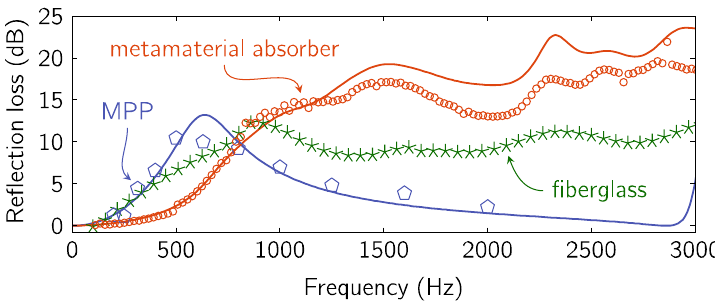
Figure 6. Reflection loss (dB) for the 5.93-cm thick designed metamaterial absorber (red curve (theory) and symbols (experiment, measured by using the impedance tube)), the micro-perforated panel (MPP) absorber with 6-cm back chamber (blue curve (theory) and symbols (experiment)), and a layer of 6-cm thick fiberglass (green symbols (experiment)). The blue curve is from Maa’s theoretical model and pentagons are the experimental data from Maa’s original paper [14,15]. It is seen that the solid red curve is about 3 to 5 dB above the red open circles, which represent the measured results. This difference is due to the fabrication error of not being able to achieve the required (very thin) thickness of the walls separating the FP